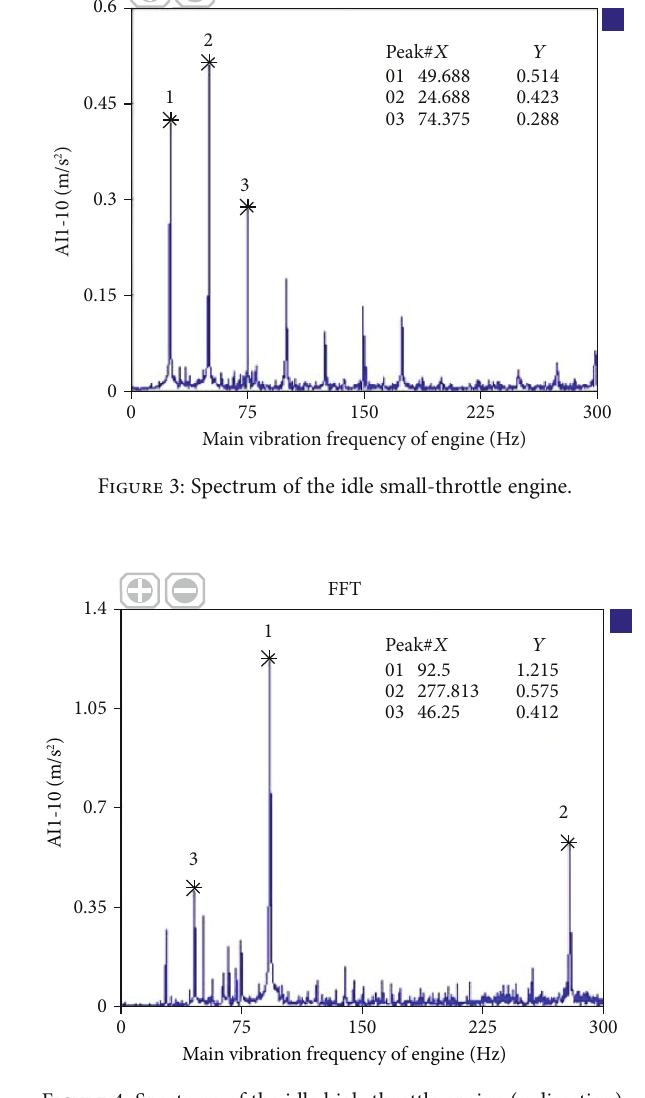
Figure 4: Spectrum of the idle high-throttle engine ( x